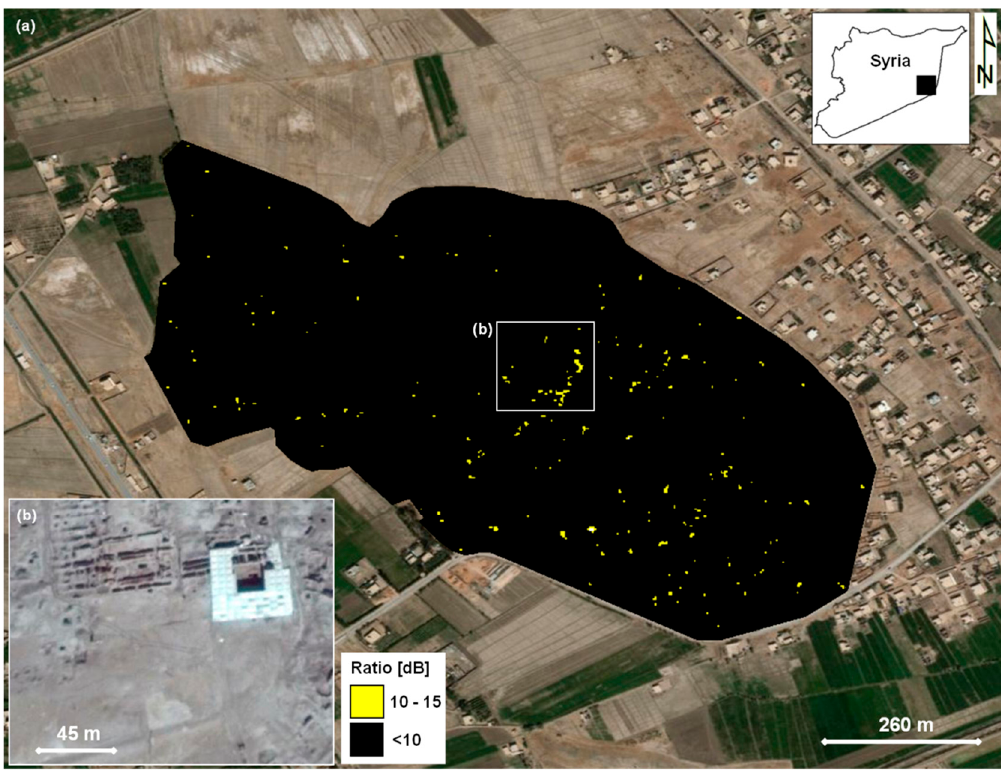
Figure 11. ( a ) Change detection map of the site of Mari (Tell Hariri), Syria, obtained by ratioing a pair of COSMO-SkyMed StripMap Himage images at 3 m resolution acquired on 10/03/2010 (prior to the civil war) and 10/08/2018 in descending mode, using an incidence angle of 40°. ( b ) The inset shows the area of the covered temple of the Royal Palace, where a pattern of increased backscatter is clearly observed. COSMO-SkyMed® Products ©ASI—Italian Space Agency—2010–2018. All Rights Reserved.